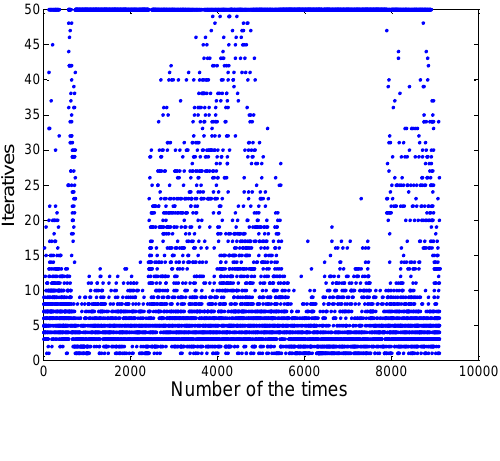
Figure 8. The iterative number of the RANSAC